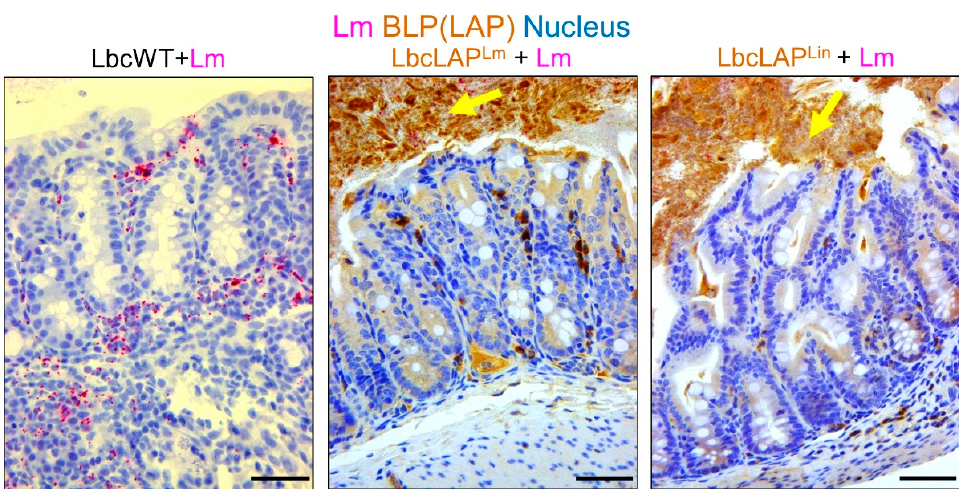
Figure 3. Biofilms formed (above) by recombinant Lactobacillus casei (Lbc) expressing Listeria Adhe- sion Protein (LAP) from L. monocytogenes (LbcLAP Lm ) or nonpathogenic L. innocua (LbcLAP Lin ) on mouse colonic villi after feeding for ten days (arrows). The wild-type Lactobacillus casei (LbcWT) did not show any biofilm formation (left panel). Bar, 25 µm. The figure was adapted with permission from Drolia et al. 2020 [51].